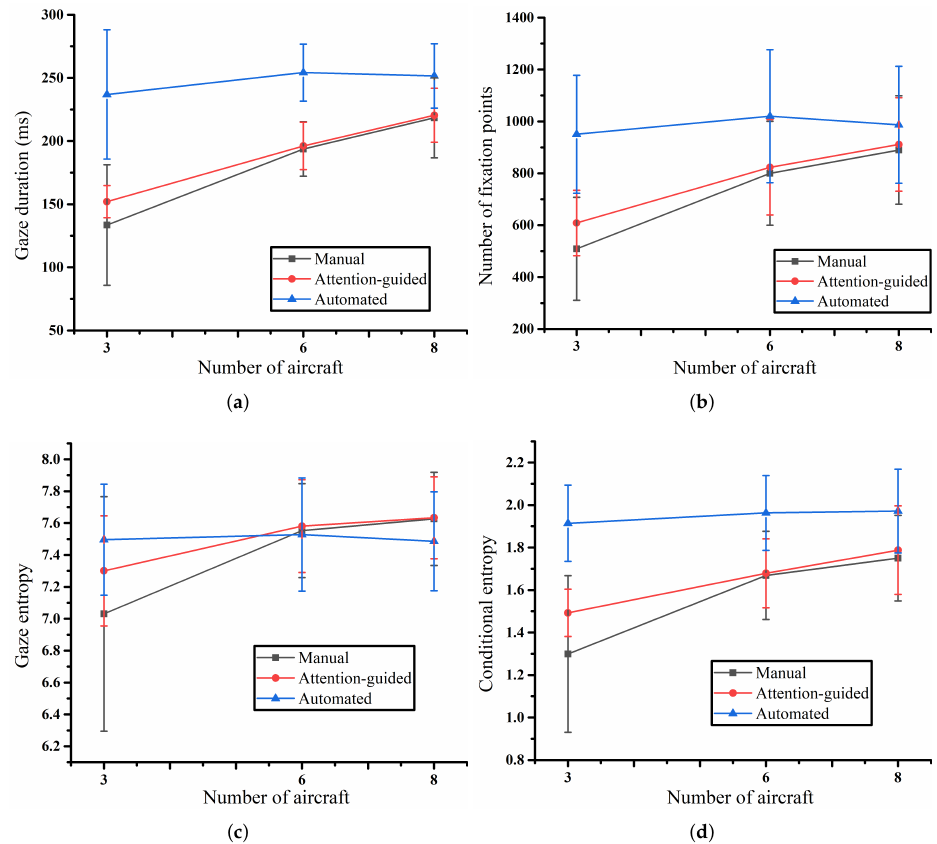
Figure 5. Statistical results on gaze behaviors. ( a ) Gaze duration, ( b ) number of fixation points, ( c ) gaze entropy, ( d ) conditional